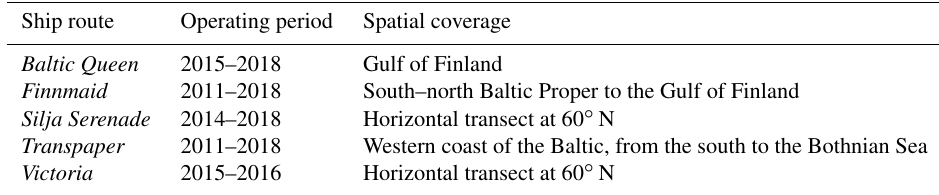
Table 2. FerryBox ship routes and periods of